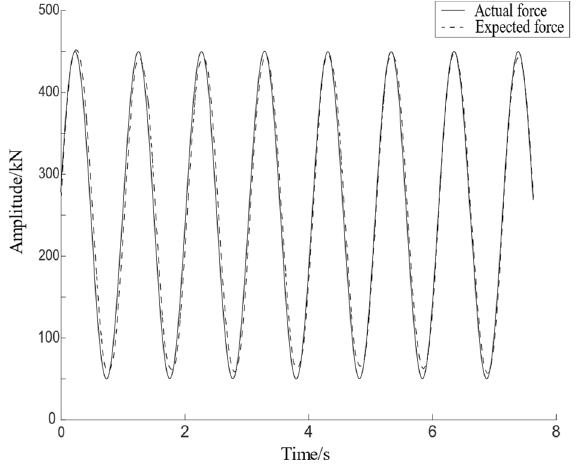
Figure 7. Simulation curve of testing machine.